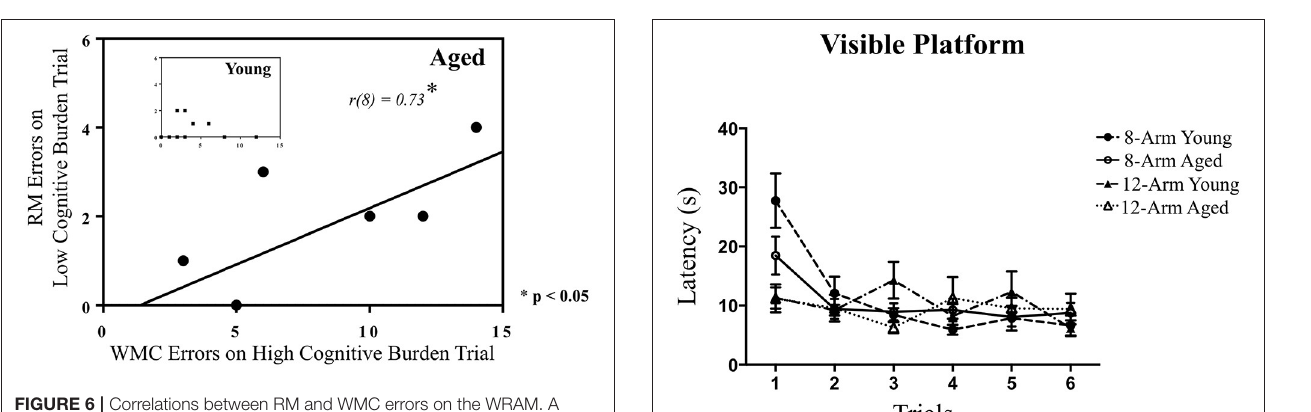
FIGURE 6 | Correlations between RM and WMC errors on the WRAM. A significant positive correlation was found between RM errors made on an early trial (Trial 2), with a relatively low cognitive load, and WMC errors made on the last trial (Trial 7), or the highest cognitive load trial, for aged rats performing on the 12-Arm WRAM on the last day of testing, but not for young rats [ R 2 = 0.53, r (8) = 0.73, * p < 0.05]. Several rats in the aged group made the same number of RM and WMC errors for this figure, resulting in the overlap of data points represented.